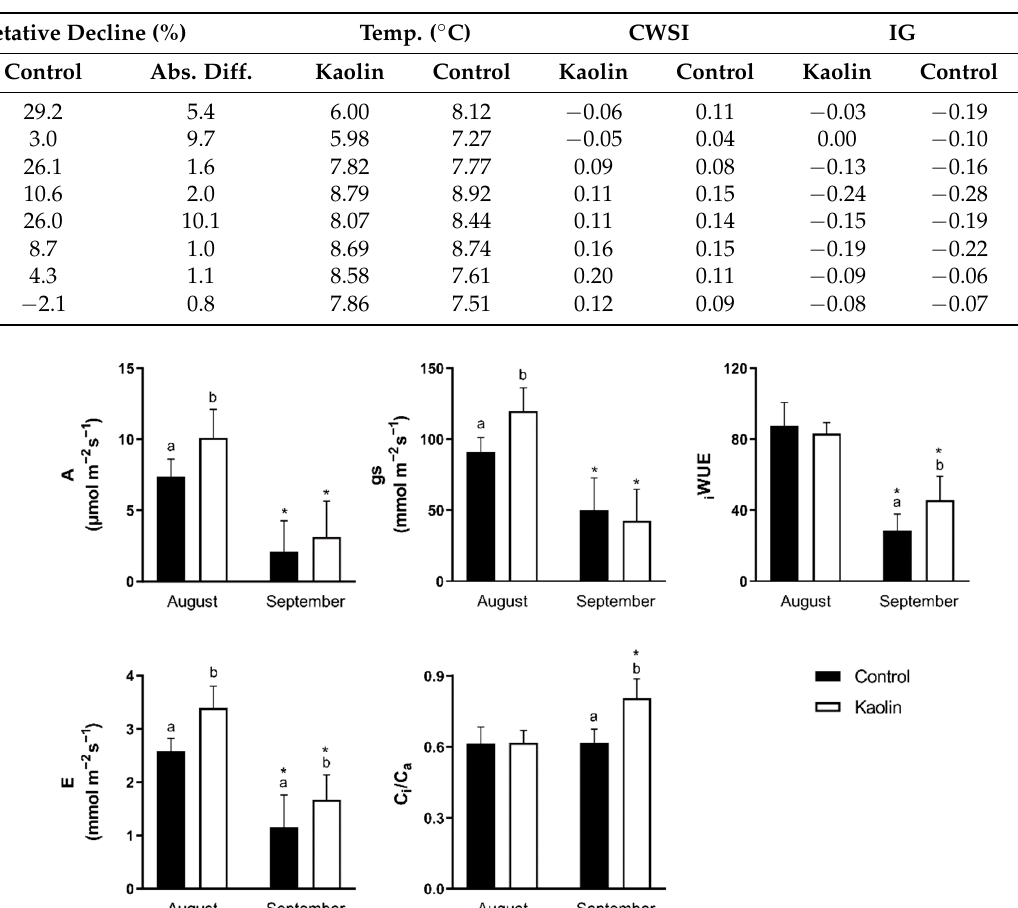
Table 4. Relative difference between the two periods for the grapevine vegetation area decline and estimated parameters from the thermal infrared imagery in each plot. Data represents the difference between September to August mean plot values of kaolin-treated plants with respect to the control